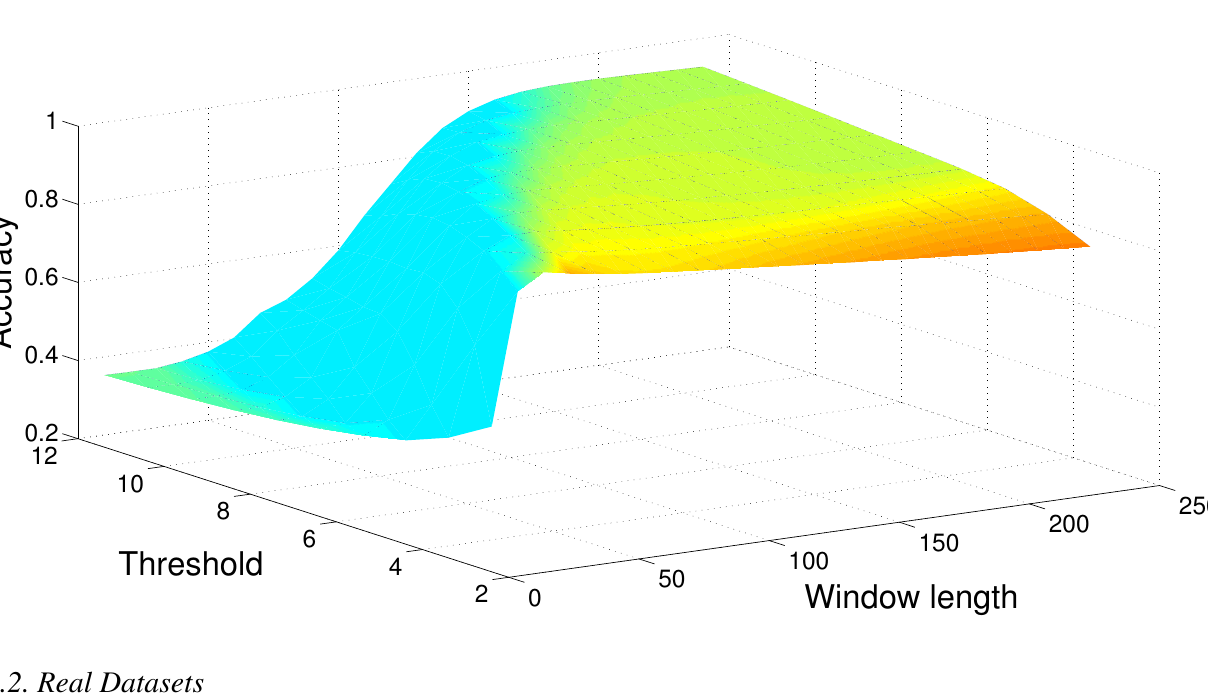
Figure 4. Parameter optimization. Sweep of window length and threshold values to find maximum accuracy